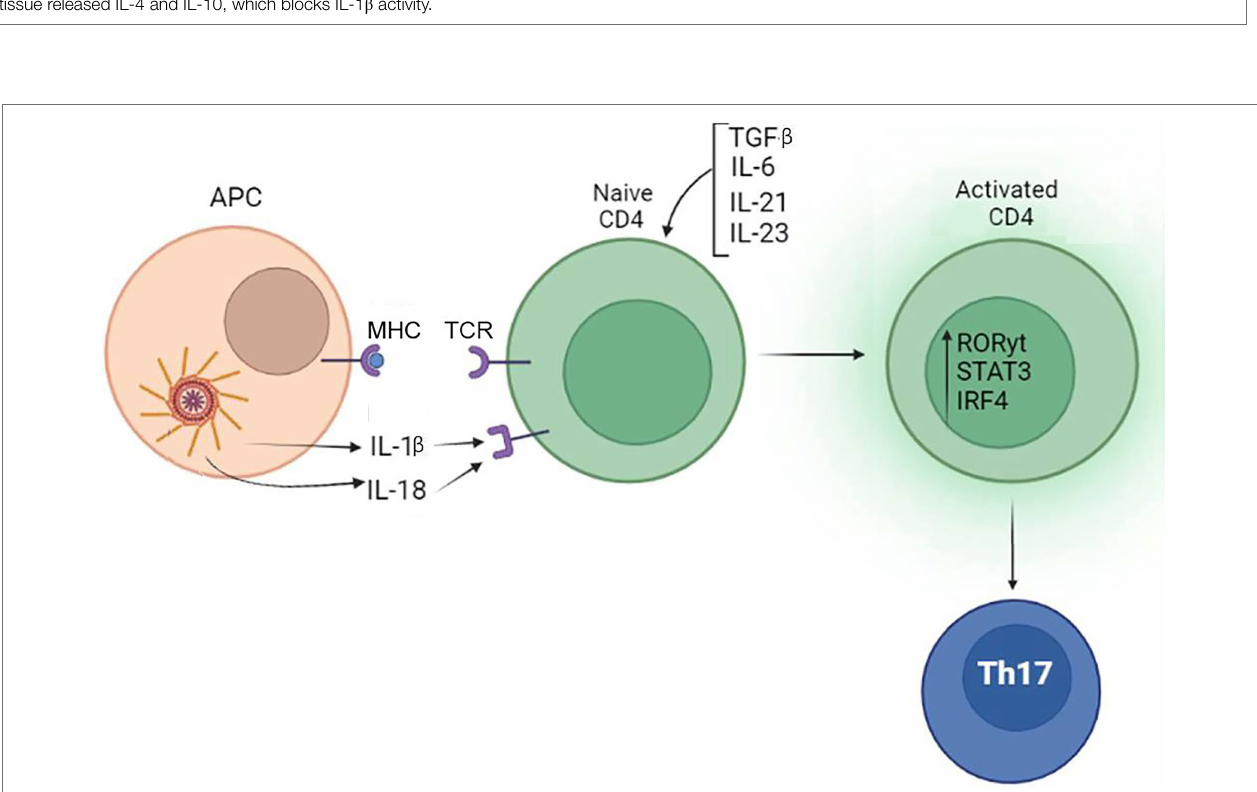
FIGURE 4 | The role of the inflammasome in the differentiation of Th2 lymphocytes. The inflammasome produces IL-33 which can promote Th2 differentiation. Another inflammasome product, IL-18, can also promote Th2 lymphocytes development only in the absence of IL-12. Additionally, Th2 differentiation is promoted by tissue released IL-4 and IL-10, which blocks IL-1 β activity.